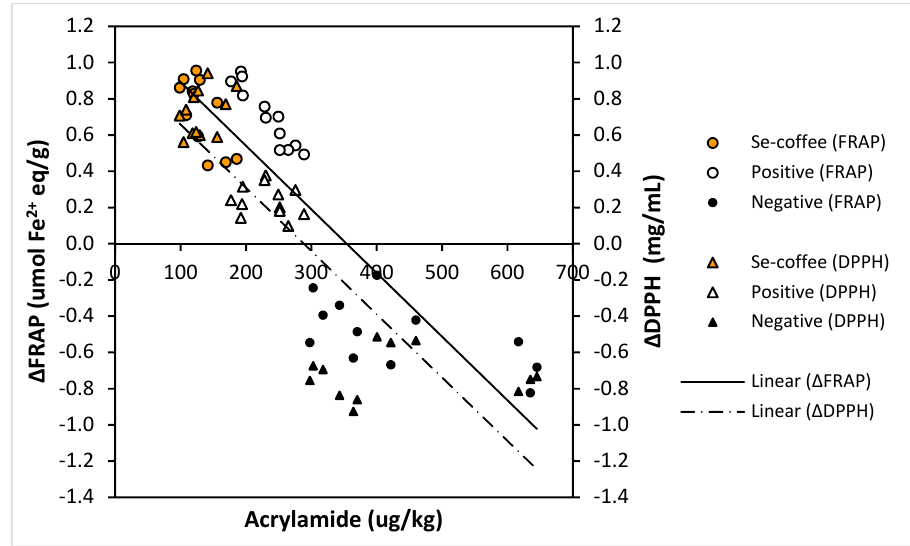
Figure 3. Correlation between acrylamide level and change of antioxidant capacities of Se-coffee (pretreated with selenium), positive control (pretreated without selenium), and negative control (untreated) measured from the difference of FRAP values ( ∆ FRAP) and DPPH EC 50 values ( ∆ DPPH) between green and roasted coffees.